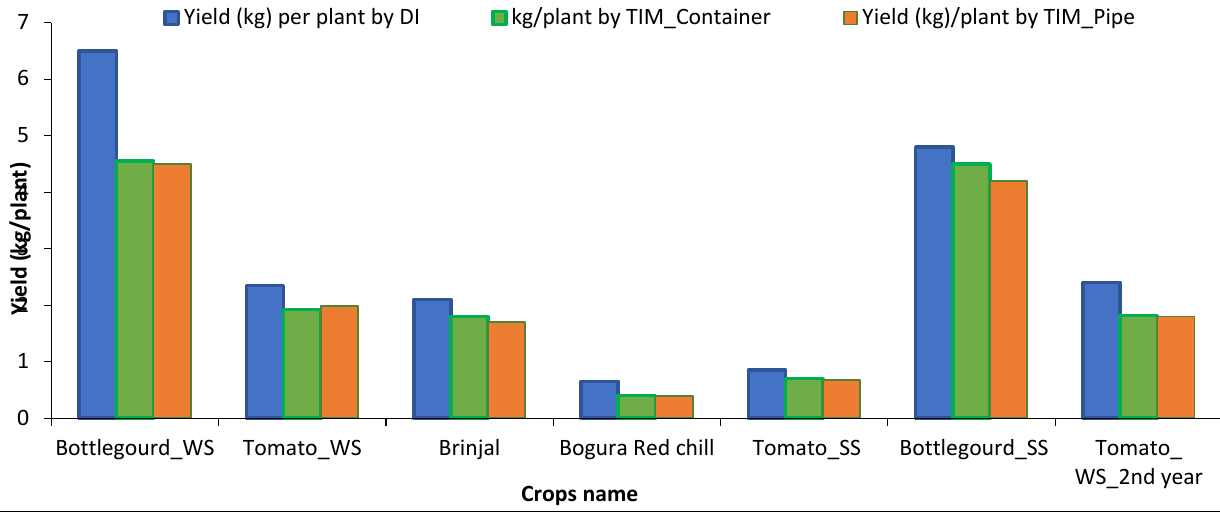
Figure 9. Yield of selected crops in URTA during drip irrigation and traditional irrigation (container and pipe).